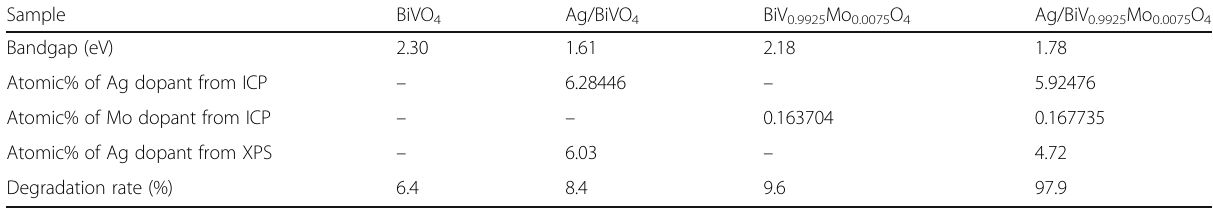
Table 1 Properties of the pure BiVO 4 , Ag/BiVO 4 , BiV 0.9925 Mo 0.0075 O 4 , and Ag/BiV 0.9925 Mo 0.0075 O 4